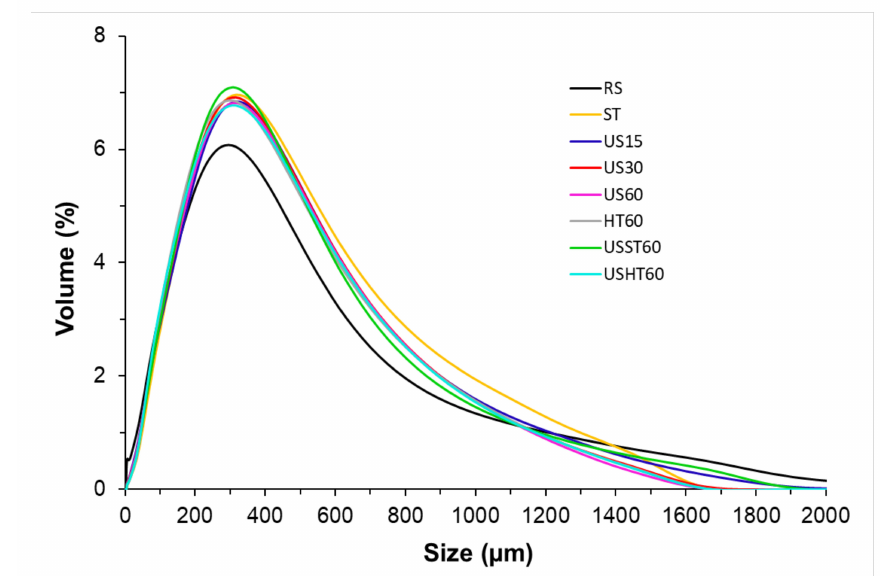
Figure 3. Particle size distribution obtained for the residual powder from the di ff erent extraction processes at a determined time (RS: rice straw, US: ultrasound, ST: stirring, HT: heating at reflux, USST, and USHT: combined treatments). The number in the sample code indicates the processing